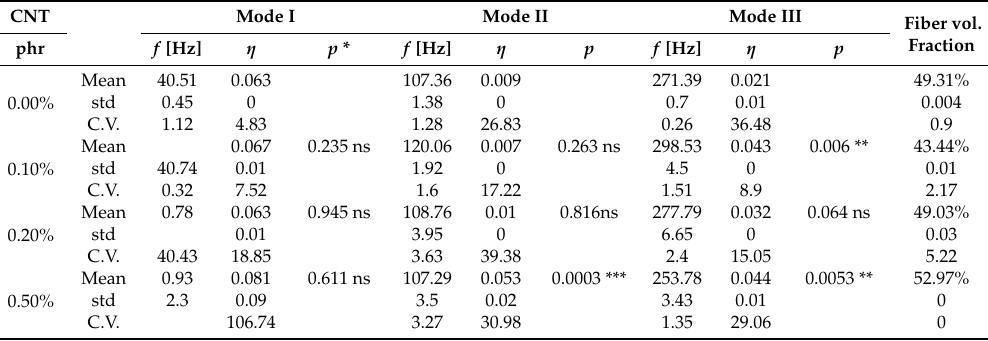
Table 4. Vibration tests